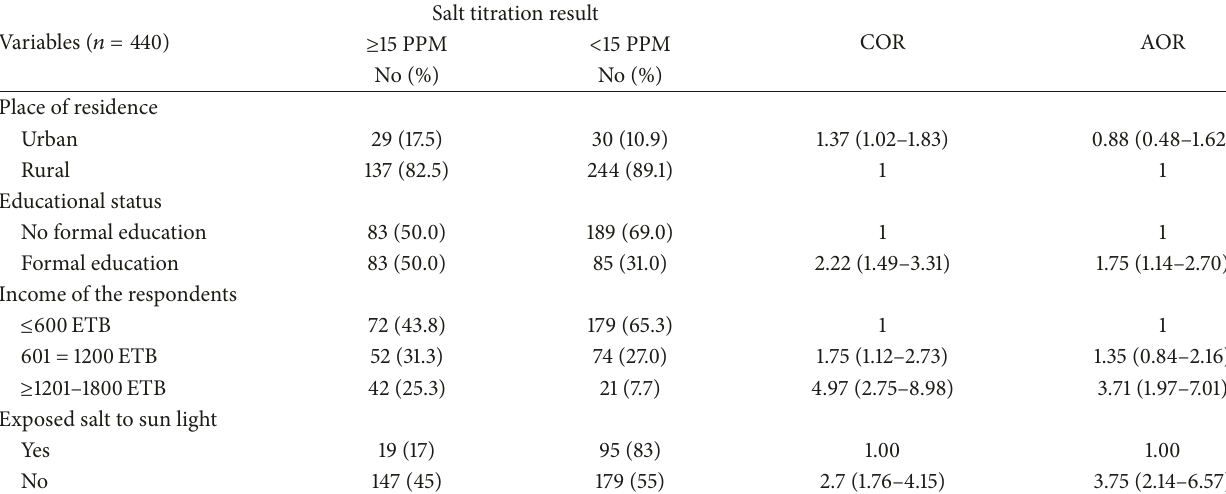
Table 5: Sociodemographic and practices factors associated with the presence of adequately iodized salt at home in multivariable logistic regression, Wolaita Sodo town and its peripheries, Southern Ethiopia